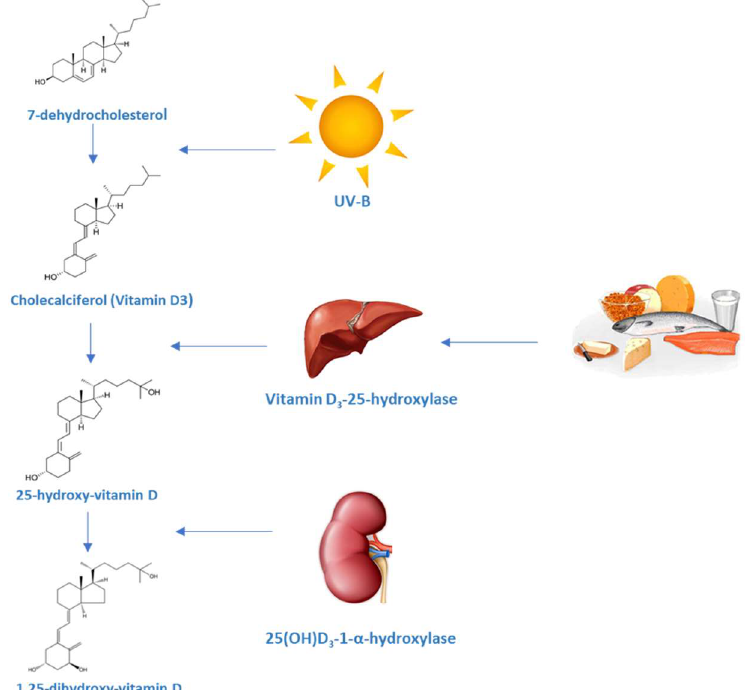
Figure 1. Synthesis of vitamin D and the vitamin D metabolic pathway. The vitamin D metabolites are transported in blood bound primarily to vitamin D binding protein (DBP) (85–88%) and